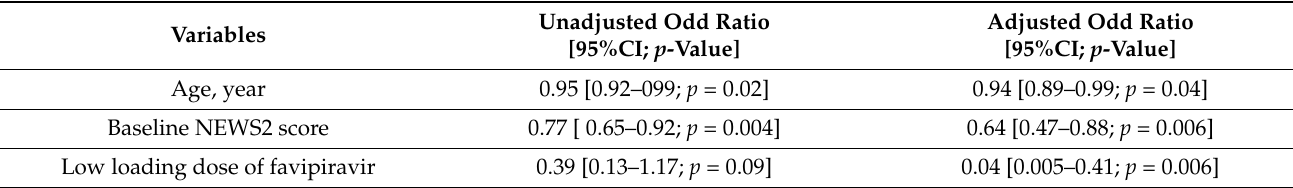
Table 3. Factors associated with Day-7 clinical